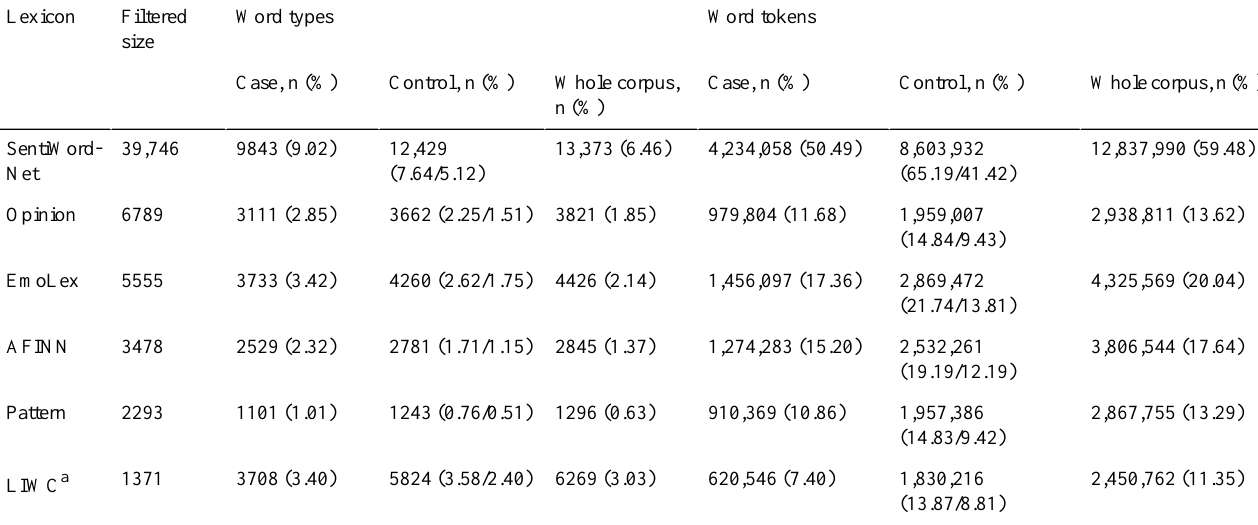
Table 5. Term type and token counts for each lexicon in case and control subcorpora and whole corpus. Percentages for control words are shown as (raw/adjusted). Figures are in descending order of lexicon (filtered) size.